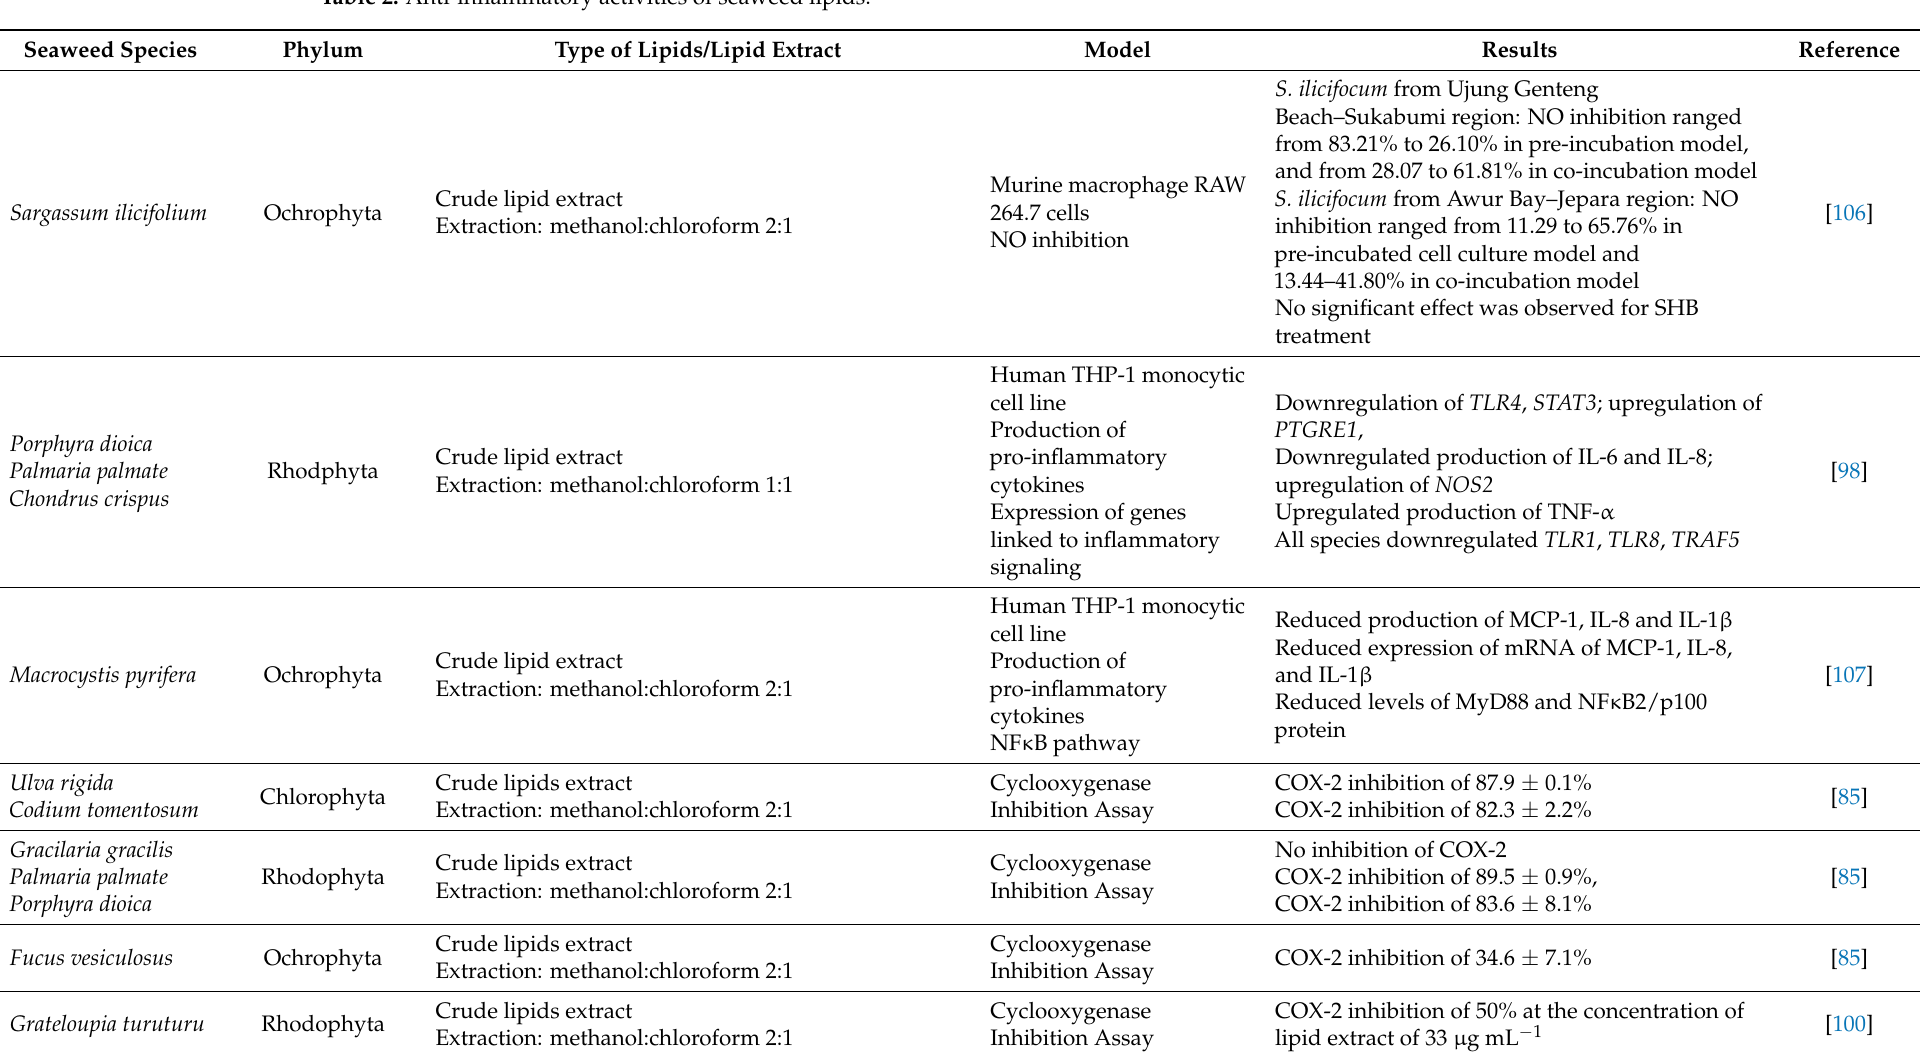
Table 2. Anti-inflammatory activities of seaweed